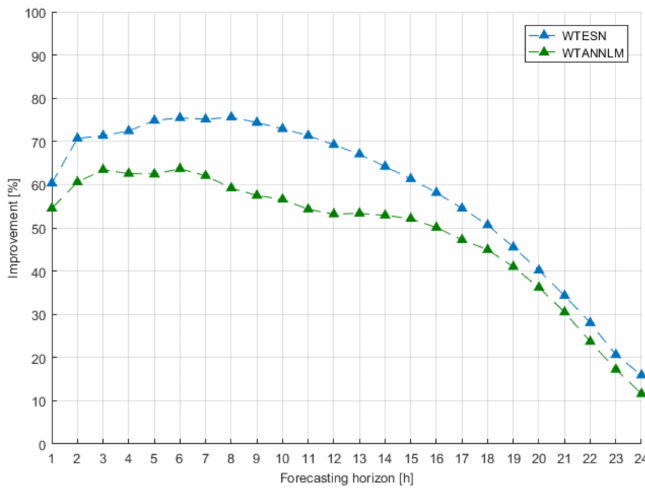
Figure 18. Improvements of NMAE with respect to PM of wind power forecasts for